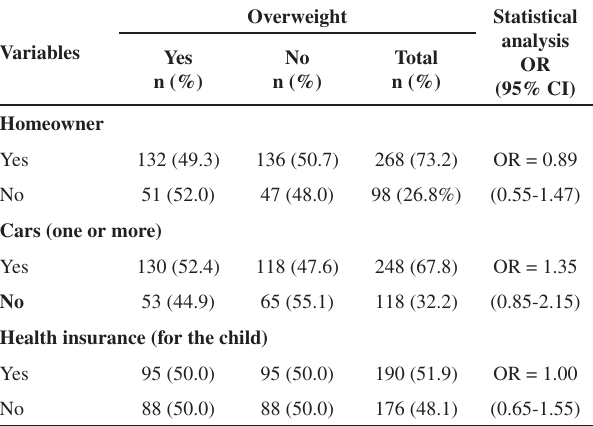
Table 1 – Socioeconomic variables and risk of overweight among pre- school children. Overweight Statistical Variables